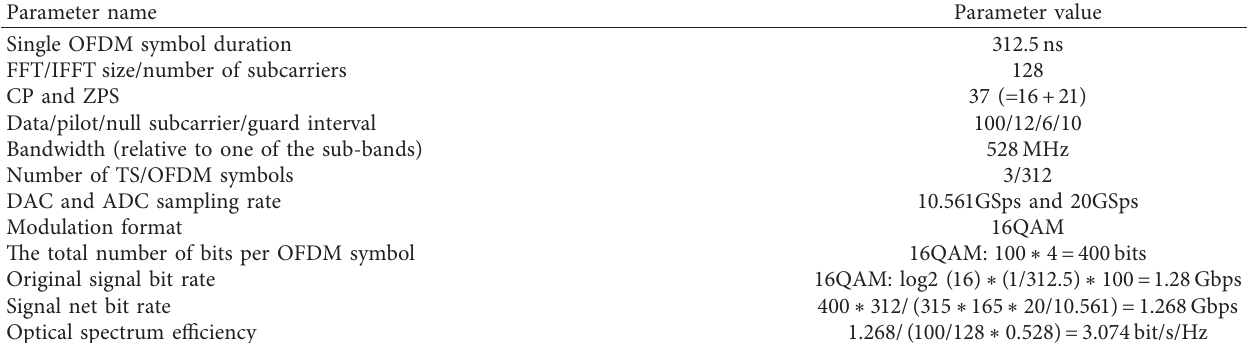
Table 1: The main parameters of the transceiver based on a single training sequence scheme.